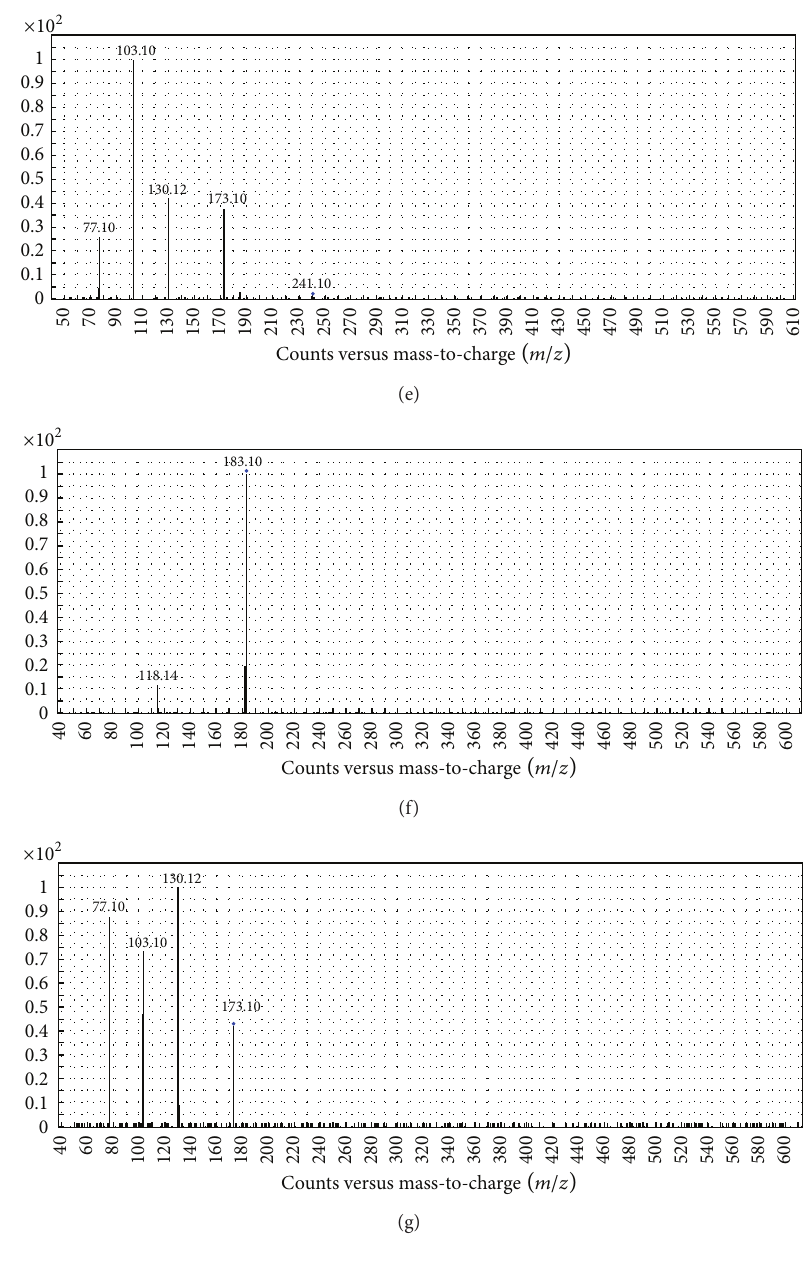
Figure 3: (a) ESI mass spectrum of compound 3c [M + H] + ion ( m/z 348.20). (b) MS 2 spectrum of m/z 348.20. (c) In-source fragmentation of compound 3c . (d) MS 2 spectrum of m/z 280.22. (e) MS 2 spectrum of m/z 241.10. (f) MS 2 spectrum of m/z 183.10. (g) MS 2 spectrum of m/z